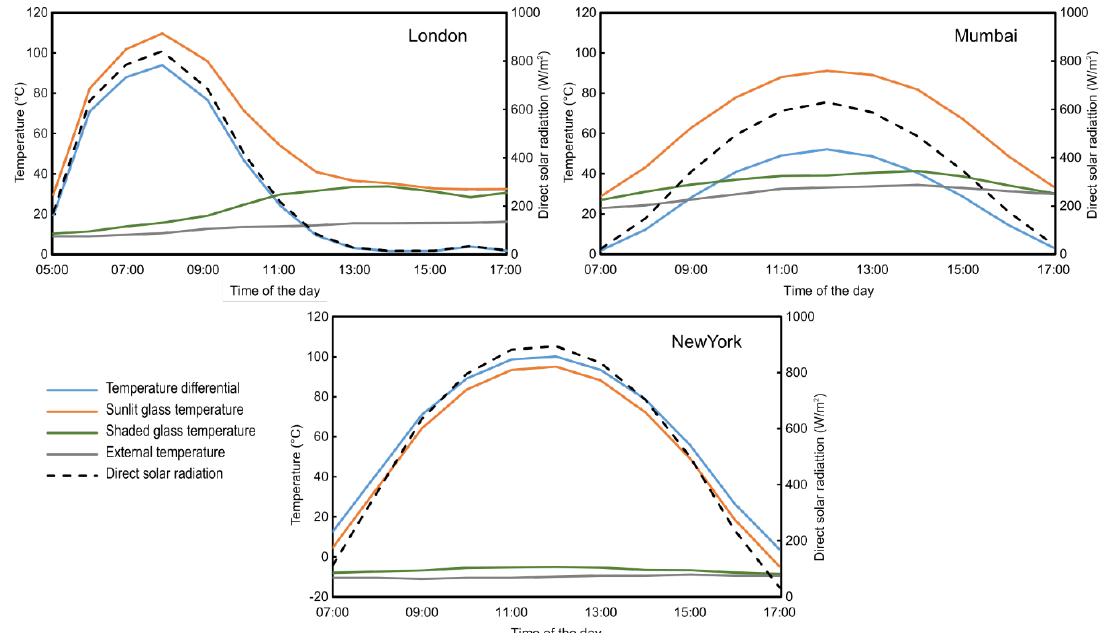
Figure 6. Daily variation of the thermally induced temperature gradients (in Kelvin) for the three analyzed configurations.